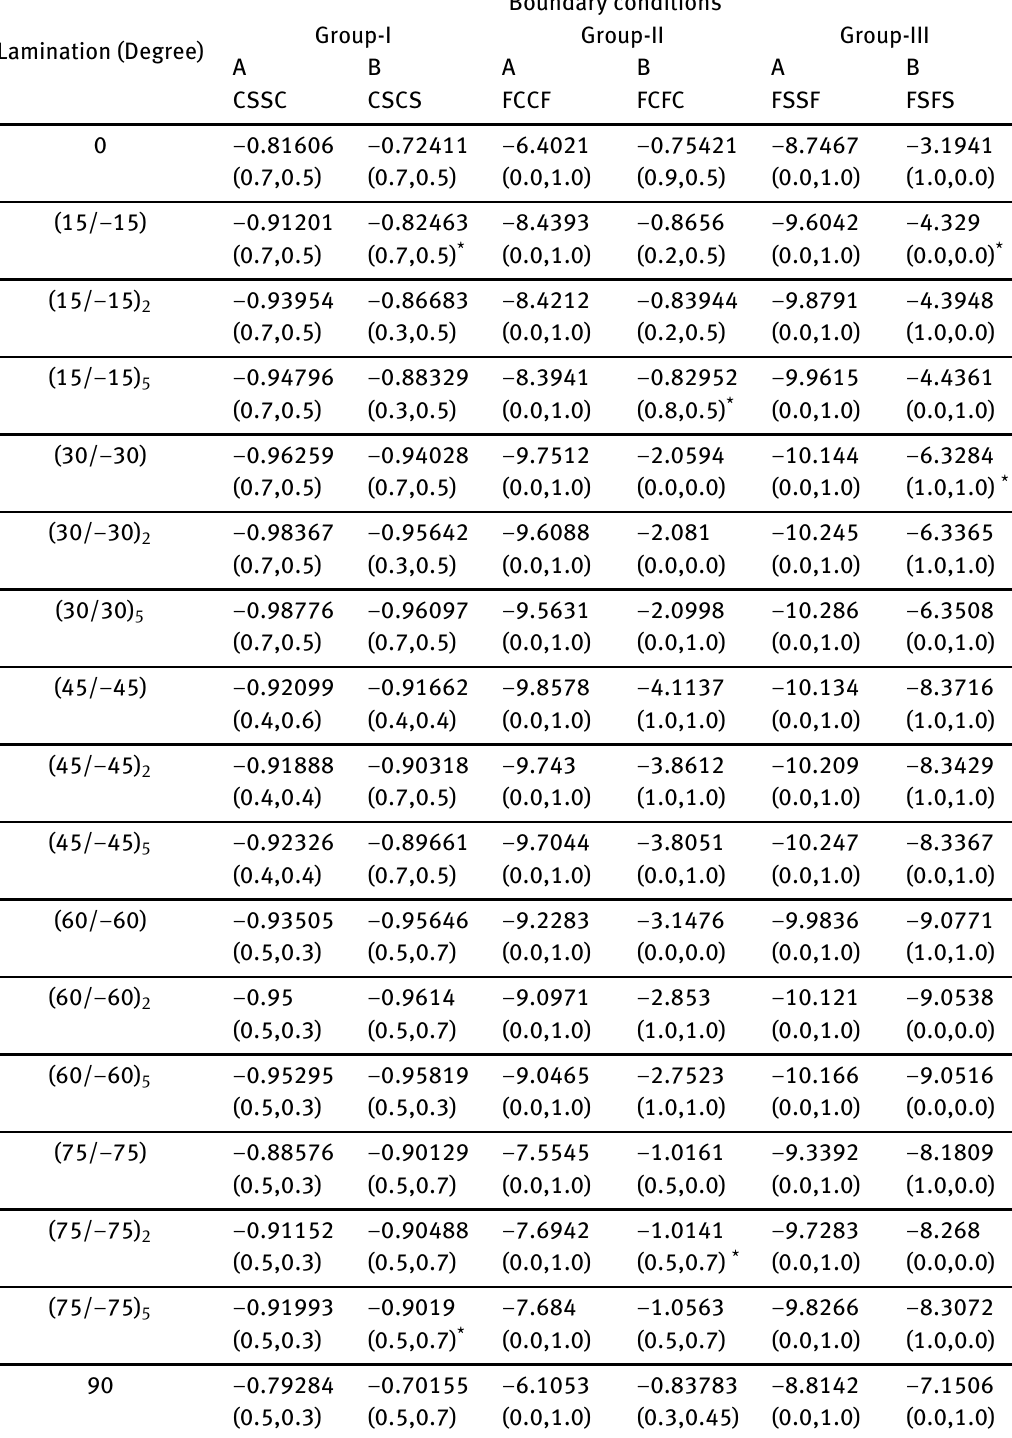
Table 9: Values of maximum non-dimensional clockwise in-plane shear (− N xy ) for different antisymmetric angle ply lamination and boundary conditions of stiffened composite hypar shell with